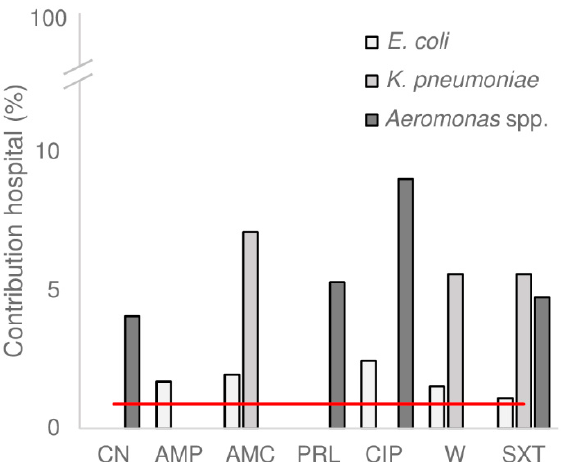
Figure 3. Contribution of hospital wastewater to the total wastewater. The contribution of hospital wastewater to the total volume of water treated by the wastewater treatment plant (WWTP) was approximately 1% (red line). The percentage of antimicrobial resistant bacteria in influent originating from hospital wastewater (grey bar plots) were calculated as explained in Section 2.5. CN = gentamicin, AMP = ampicillin, AMC = co-amoxiclav, PRL = piperacillin, CIP = ciprofloxacin, W = trimethoprim, SXT = co-trimoxazole. Antimicrobials with only one resistant isolate in influent were not included in the calculation.